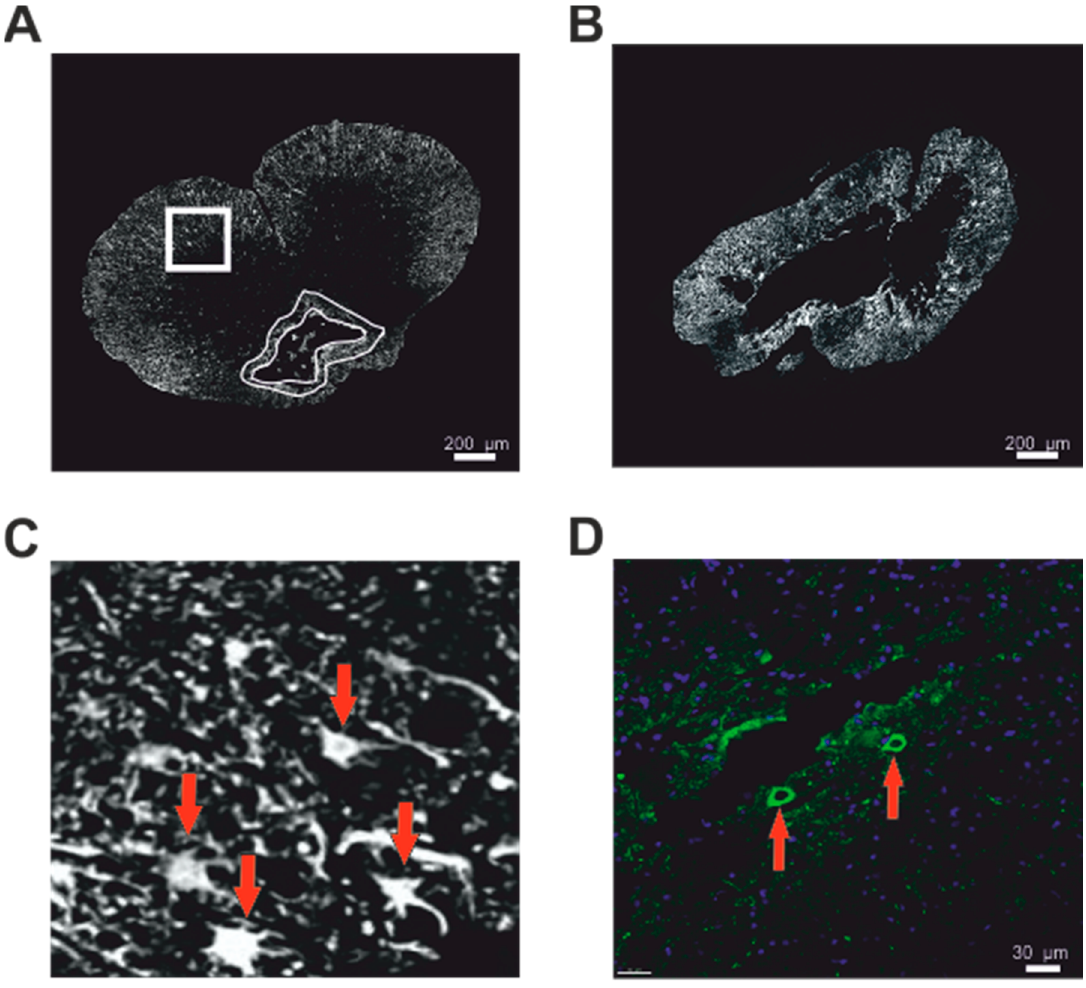
Figure 4. ( A —4 mm cranially from the lesion epicentre, B —lesion epicentre at Th8) Volumetric measurement of the astrogliosis around the central cavity was performed in the GFAP stained immunohistochemical images. ( C ) Detailed view with red arrows pointing to protoplasmic astrocytes in GFAP staining. ( D ) The impact of the lesion on the survival of motoneurons was evaluated using the ChAT +/ DAPI immunostaining: red arrows show the